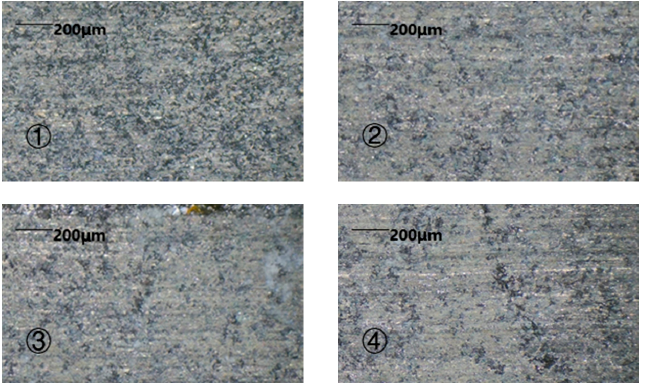
Figure 9. Resulting morphology for different voltage values: 1 (cid:13) 3 V; 2 (cid:13) 4 V; 3 (cid:13) 5 V; 4 (cid:13) 6